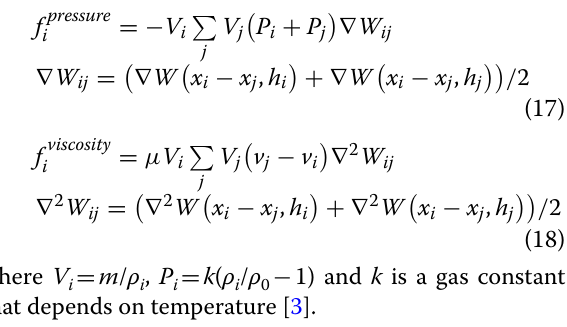
where the current density ρ interpolation from its neighboring particles [3, 9] using Eq.